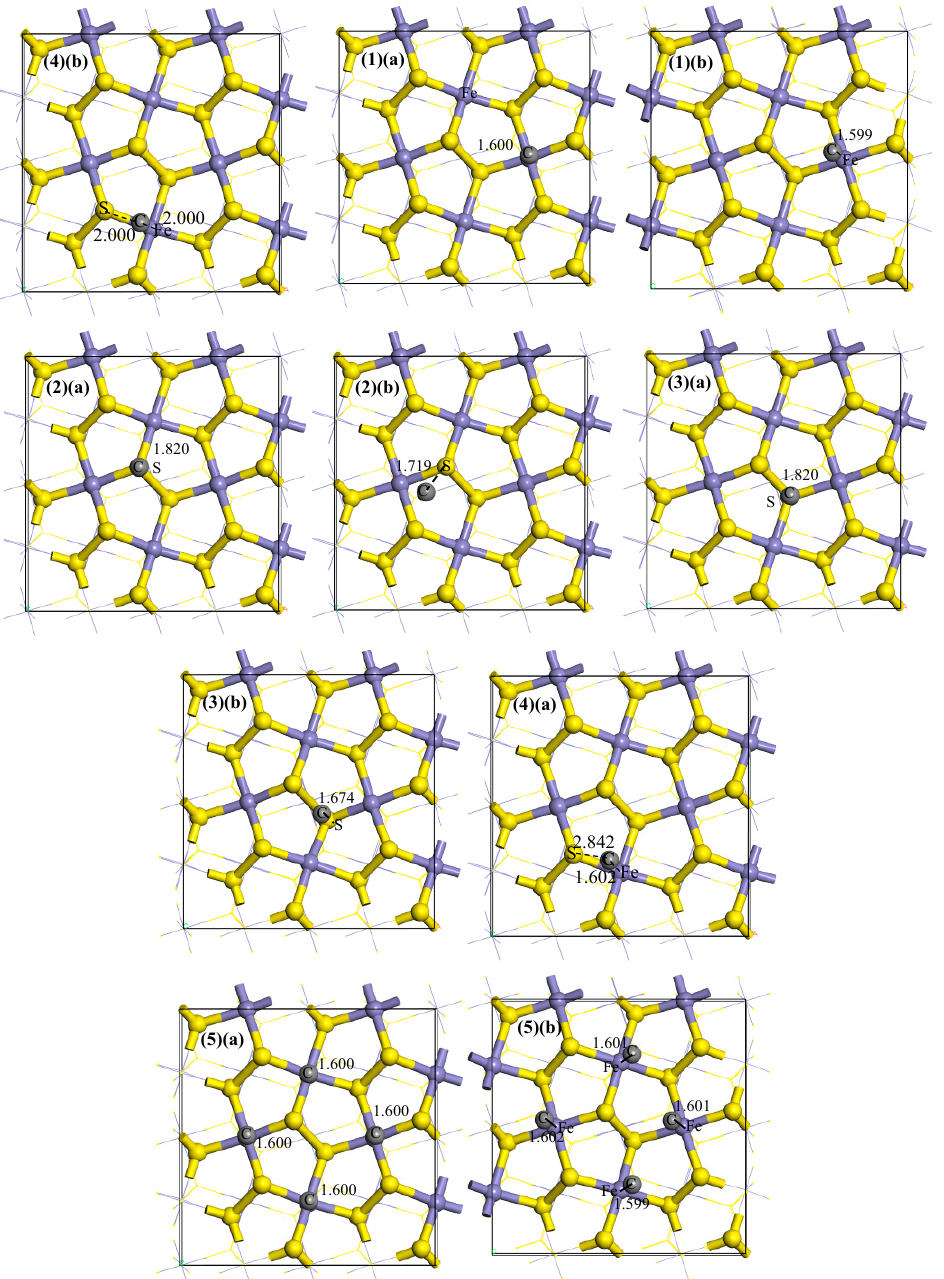
Figure 1. The initial ( a ) and equilibrium ( b ) adsorption models of one carbon atom on the coal pyrite surface for ( 1 ) F; ( 2 ) HPS; ( 3 ) LPS; ( 4 ) FS; and ( 5 ) F-4C.